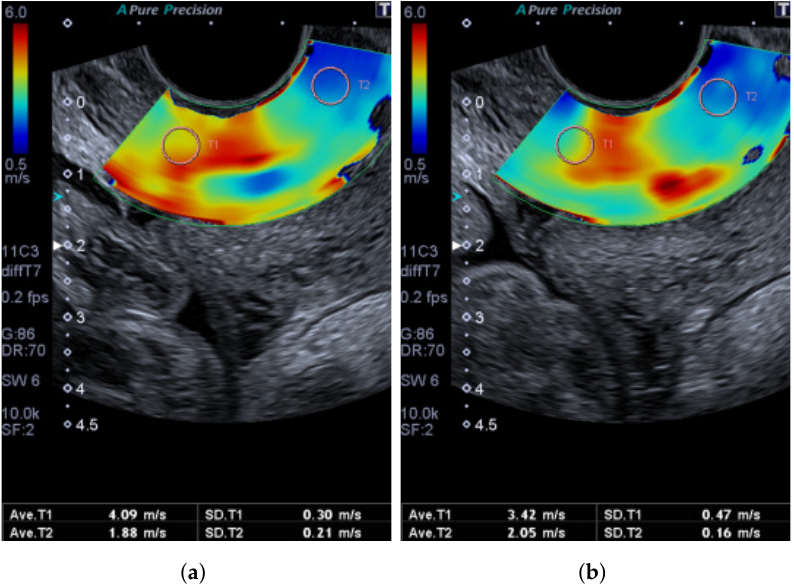
Figure 7. ( a , b ) Sample patient elastograms taken with the normal measurement method with minimal pressure